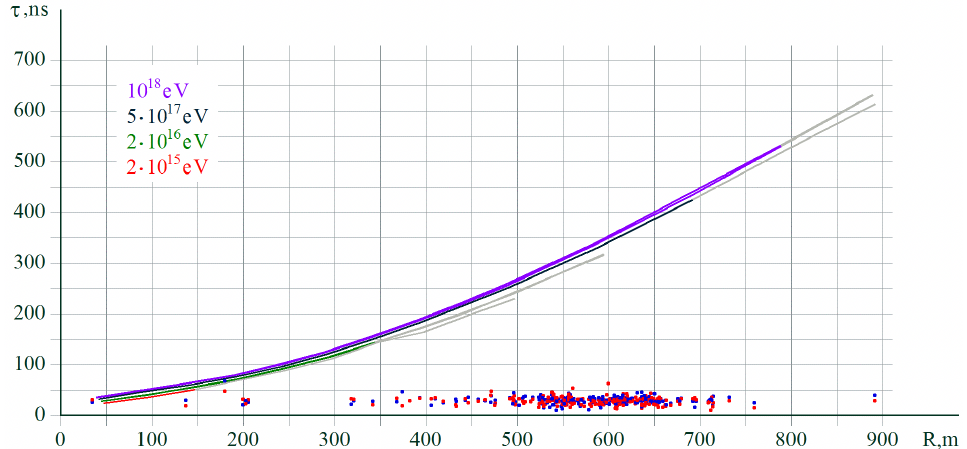
Figure 2. Solid lines: the particle density distribution ρ ( R ) in simulated EAS disk versus distance from axis for different energies shown by different colours, depending on energy of the CR. Blue dots: cumulative particle density for each bimodal pulse vs. distance to EAS axis, adapted from Beznosko et al., 2019 [4].